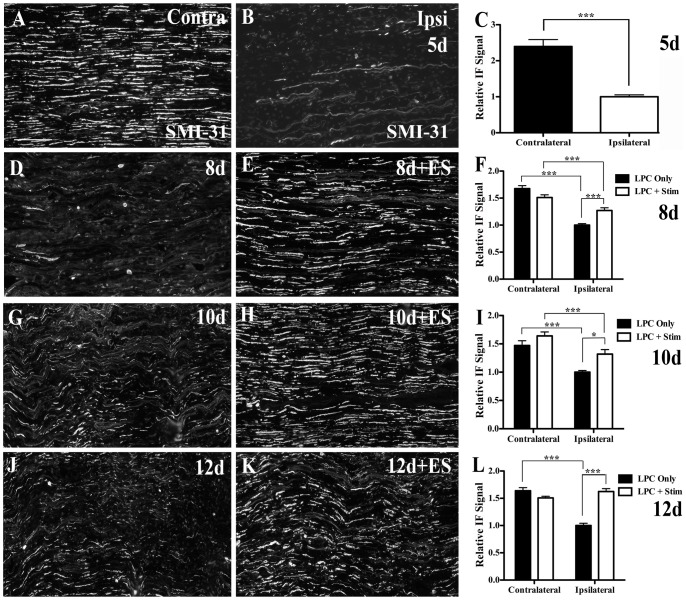
Increased neurofilament phosphorylation in demyelinated nerves subjected to ES.Representative photomicrographs from FG-positive (i.e focally demyelinated) areas of longitudinal tibial nerve sections processed for phosphorylated neurofilament (SMI-31) IF reveal extensive loss of SMI-31 IF (B) as compared to contralateral control nerves which displayed intense SMI-31 immunoreactivity (A). Temporal analysis of LPC focal demyelination +/- ES as indicated in days post-LPC. Note: In the LPC+Stim group there was dramatically increased SMI-31 IF signal apparent as early as 8d post-LPC (3d post-ES; D), which was increasingly stronger in the 10d (5d post-ES; F) and 12d (7d post-ES; H) tissue. In contrast, in the LPC only group there was just a slight increase in SMI-31 IF signal beginning 10d post-LPC. Note: for each time point examined, all values obtained were normalized to the mean value of the Average Gray per micron2 readings for the nerves ipsilateral to LPC treatment for the LPC only animal on that slide and for that time point. N = 4-6 animals analyzed per condition; regions quantified per condition: 45 ipsi and 59 contra (5d, LPC only); 57 ipsi and 82 contra (8d, LPC only); 83 ipsi and 72 contra (8d, LPC+Stim); 72 ipsi and 70 contra (10d, LPC only); 83 ipsi and 72 contra (10d, LPC+Stim); 75 ipsi and 82 contra (12d, LPC only); 50 ipsi and 41 contra (12d, LPC+ES). Scale bar = 100 µm.